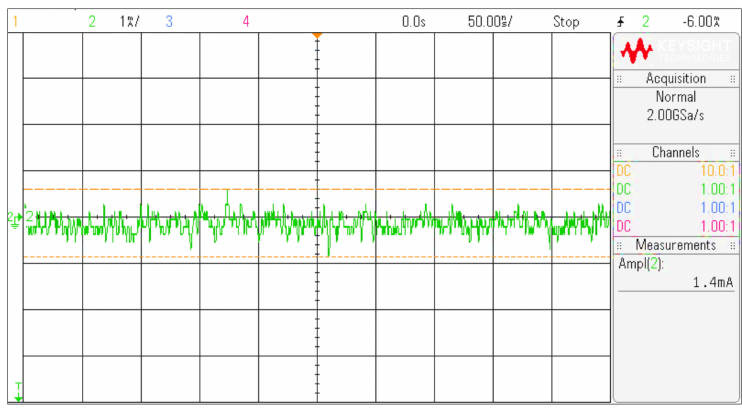
Figure 20. Input current of the piezoelectric vibration transducer (PVT). Table 6. Comparison between simulation and experimental outputs.